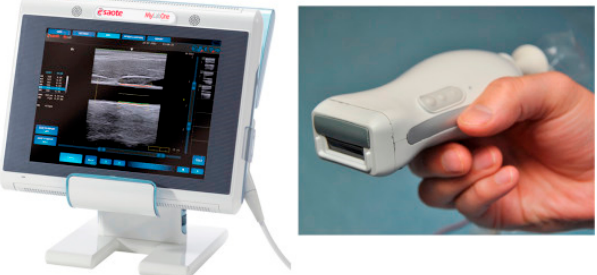
Figure 14. Portable imaging scanner combining photoacoustics and ultrasound. Left is the ultrasound scanner system and right is the picture of the probe integrating the laser module and ultrasound transducer array. Reprinted with permission from K. Daoudi, P.J. van den Berg, O. Rabot, A. Kohl, S.